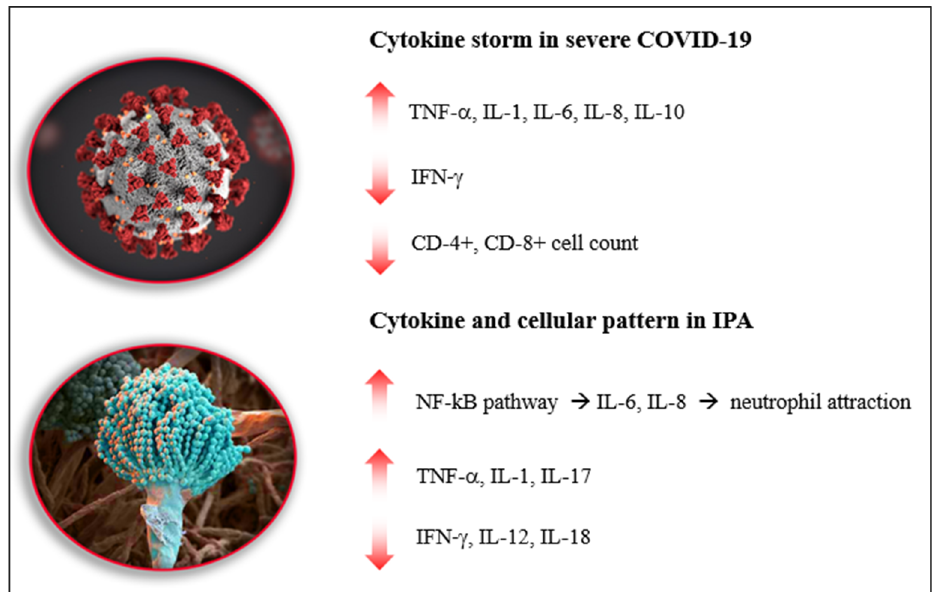
Figure 1. Cytokine expression during COVID-19 related cytokine storm and IPA–related immune dysregulation. Legend. COVID-19: Coronavirus disease 2019; CAPA: COVID-19 associated pulmonary aspergillosis; IPA: invasive pulmonary aspergillosis.